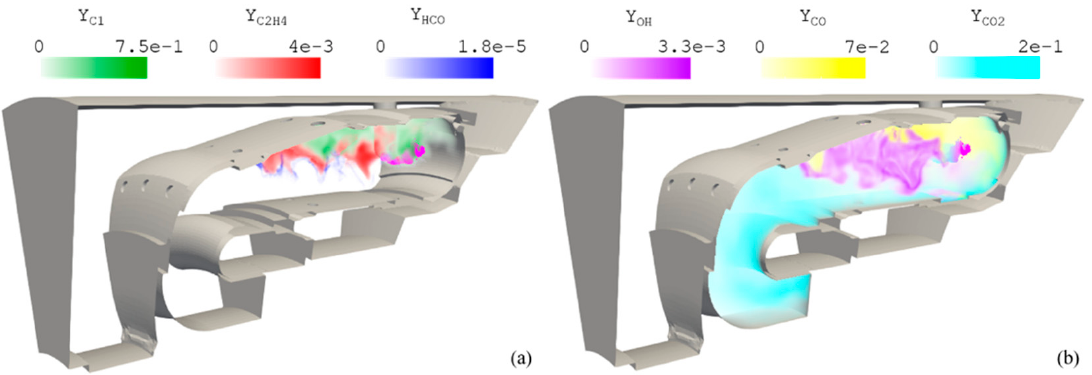
Figure 17. Instantaneous spray distribution (in magenta), together with volumetric renderings of ( a ) C1, C 2 H 4 , and HCO and ( b ) OH, CO, and CO 2 .